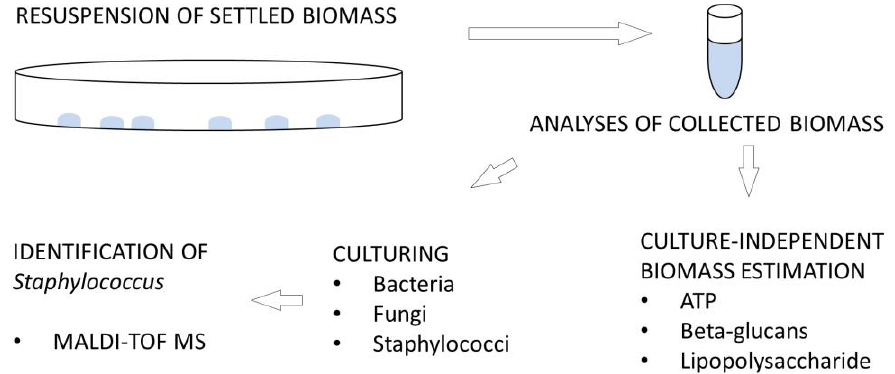
Figure 2. Schematic representation of the analyses performed on the samples.